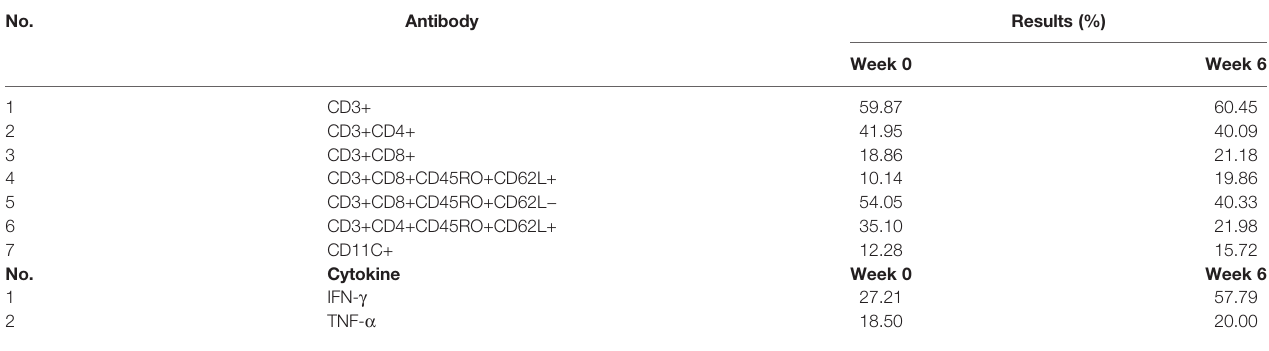
TABLE 2 | The distribution of lymphocyte subsets and the secretion of cytokine. No.